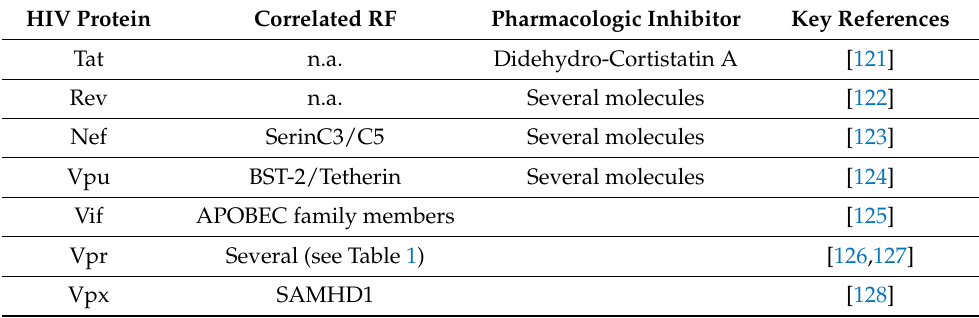
Table 3. Pharmacological targeting of HIV accessory